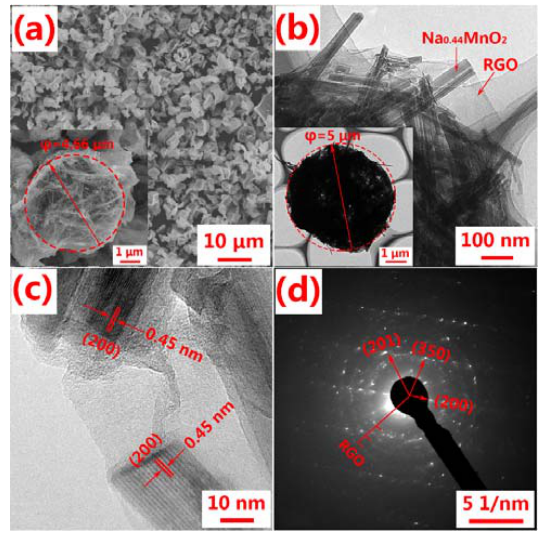
Figure 5. The morphology and structure of the Na 4 Mn 9 O 18 ‐ RGO. ( a ) SEM image; ( b ) TEM image; ( c ) HRTEM image; ( d ) SAED pattern.